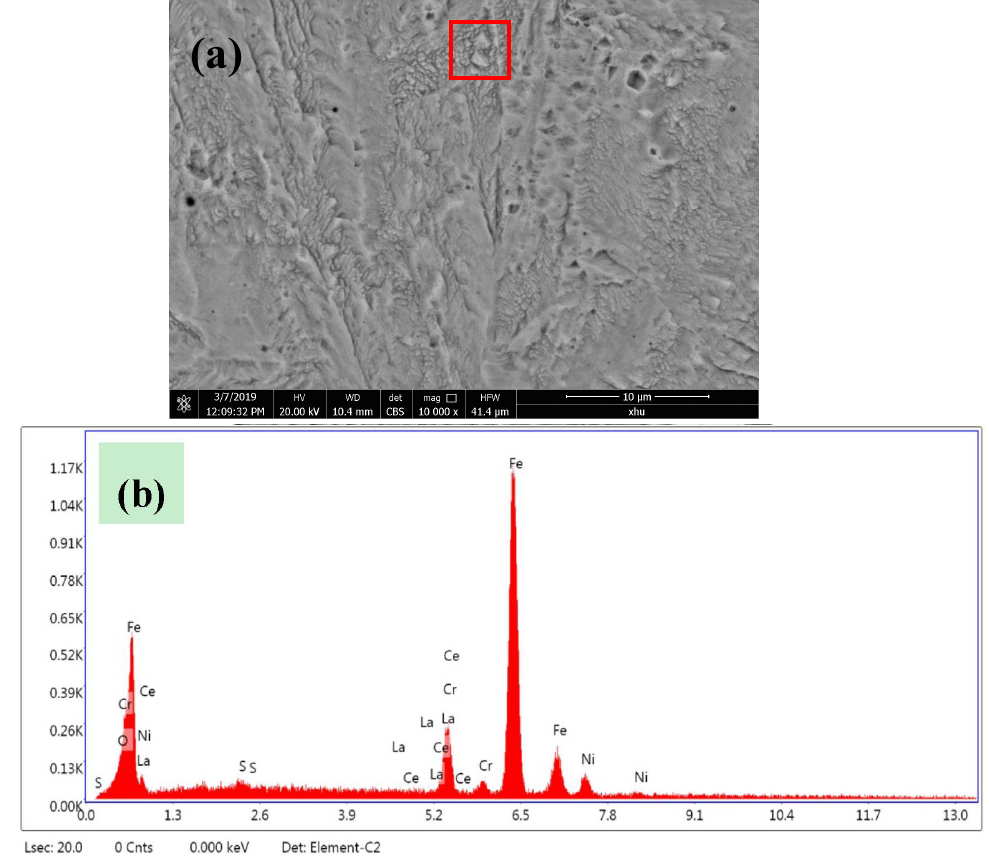
Figure 9. ( a ) The structure of the cladding layer; ( b ) EDS result for the corresponding area in ( a ). Electron probe microanalysis (EPMA) was used to analyze the distribution of Ce, La and O in the cladding layer; the mapping results are presented in Figure 10. Ce and La were evenly distributed in the cladding layer (Figure 10a,b), while O was enriched at the grain boundaries (Figure 10c). During the laser cladding process, Ce and La react metallurgically with O and S in the molten pool to form oxides, sulfides and sulfur oxides of rare-earth metals.